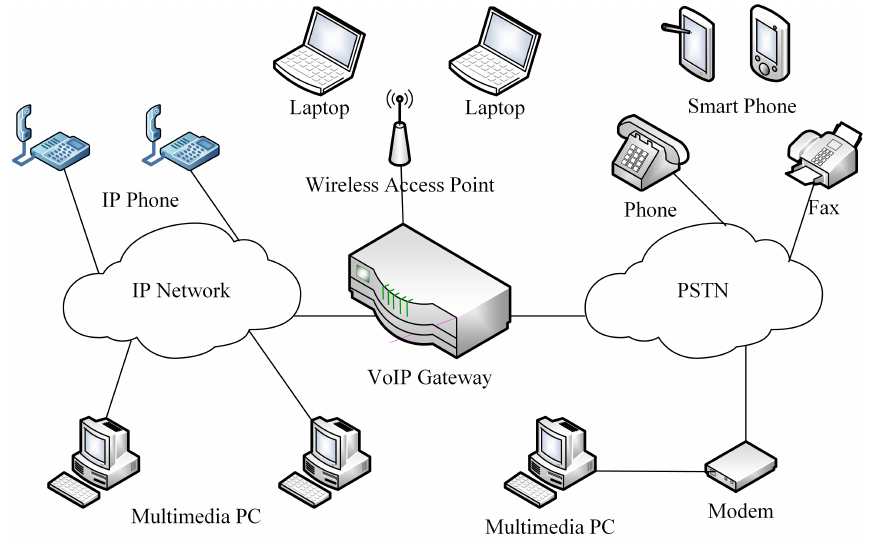
Figure 1. Primary components of the VoIP